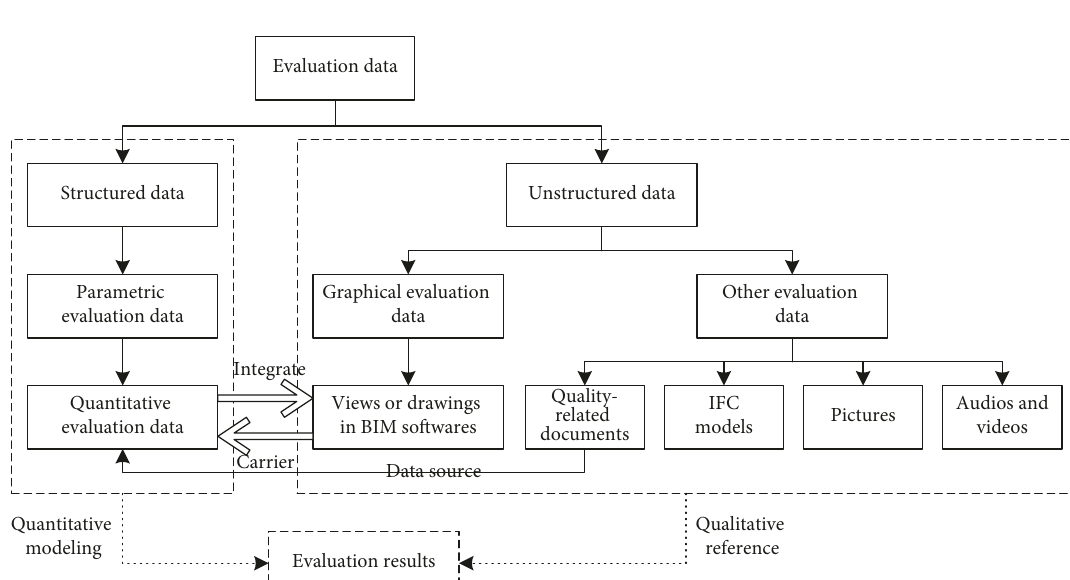
Figure 7: Data classification of quality evaluation.